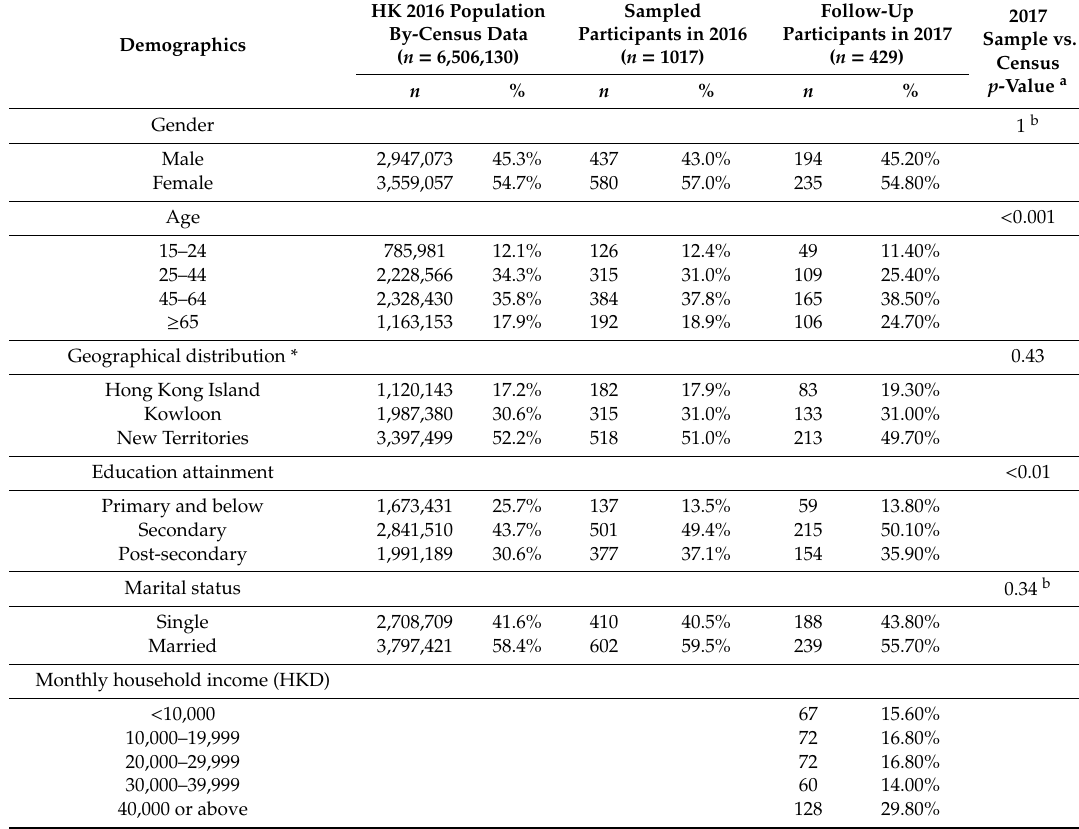
Table 2. Descriptive statistics of socio-demographic variables, history of chronic diseases and health perception of subjects in 2017 follow-up survey, with comparison to the major socio-demographic characteristics in Hong Kong Census 2016 and 2016 baseline